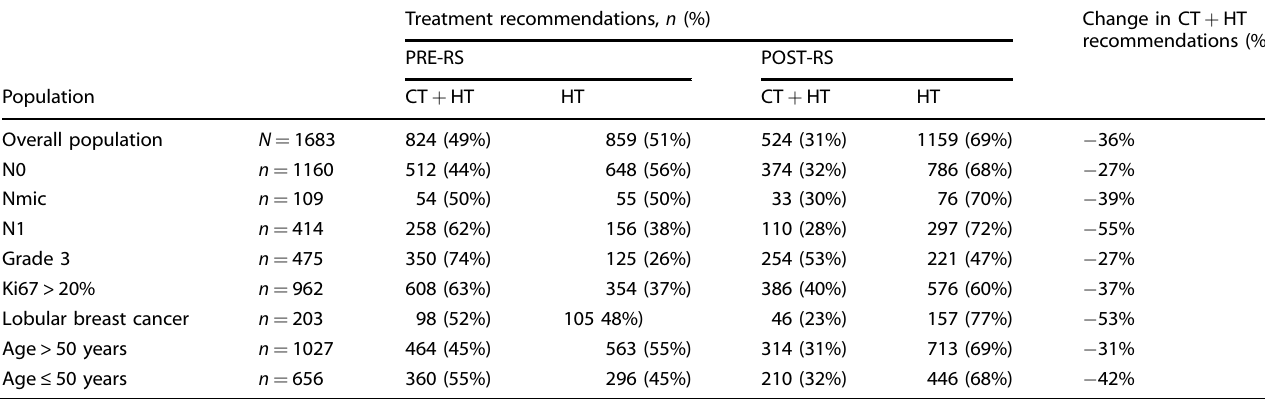
TABLE 3. Recommendations by the treating physician regarding adjuvant anti-tumor therapy before (PRE-RS) and after availability (POST-RS) of the Recurrence Score result. For these analyses, patients with recommendations other than CT + HT or HT were